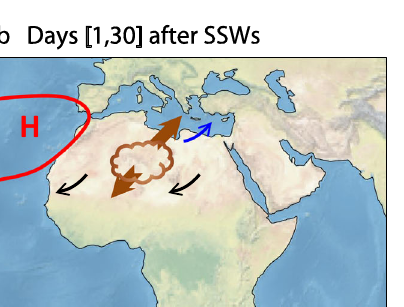
The associated northeasterly trade winds pick up and transport much of the dust aerosols southwestward. Meanwhile, the Eastern Mediterranean is under the in fl uenceofmidlatitudewesterlies.DuringSSWepisodes(panel b ),thesubtropical ridge retreats to the North Atlantic Ocean. Weaker northeasterly trade winds pick up and transport less dust aerosols southwestward, while southwesterly winds are more likely to occur over the Eastern Mediterranean, increasing northward dust transport. Made with Natural Earth. Free vector and raster map data @ naturalearthdata.com.